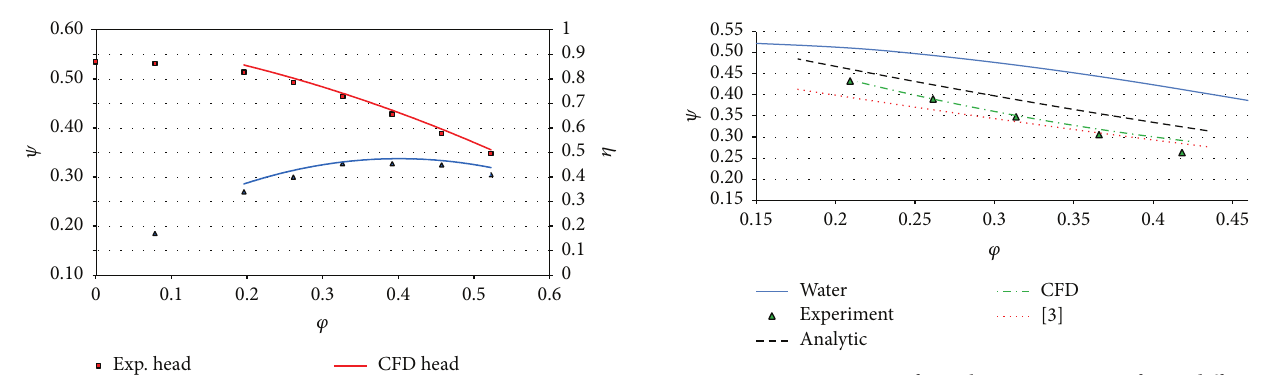
Figure 7: Comparison of resultant 𝜓 - 𝜑 curve from different methods ( ] = 90 cSt).